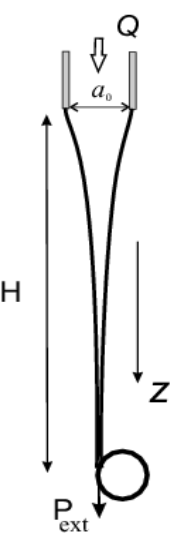
Figure A2. Schematic picture for the fiber spinning.